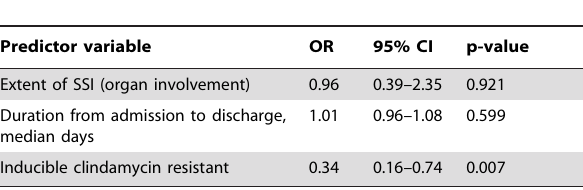
Table 4. Multivariate logistic regression analysis of factors associated with MRSA